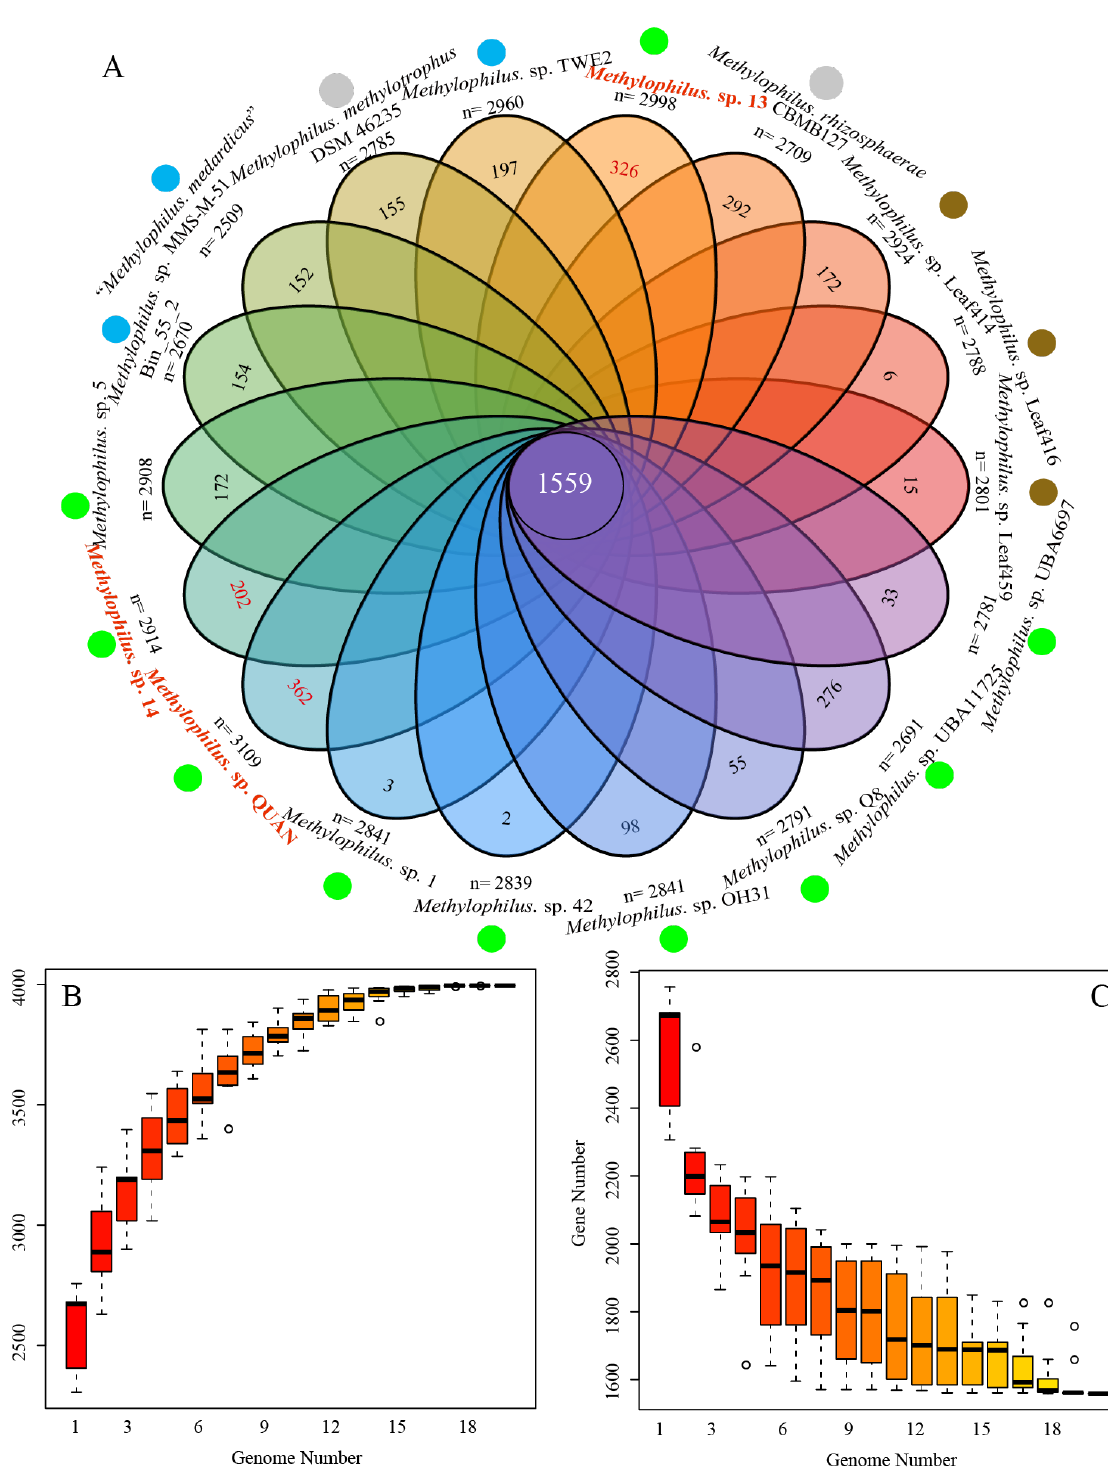
Table S2). In summary, the strains isolated from the leaf and aquatic habitats showed dif- ferences in functional genes, and the strains isolated from water and sediment had a high similarity on the whole, even if differences existed.